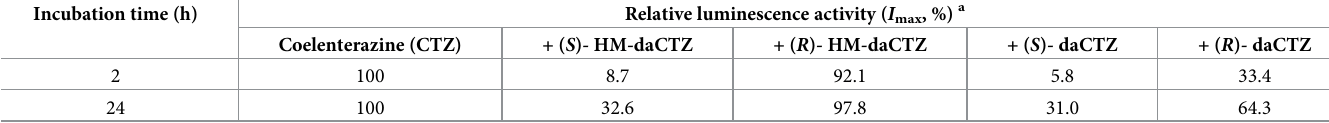
Table 1. Inhibition of aequorin regeneration form apoAequorin and coelenterazine in the presence of chiral deaza-analogs. Incubation time